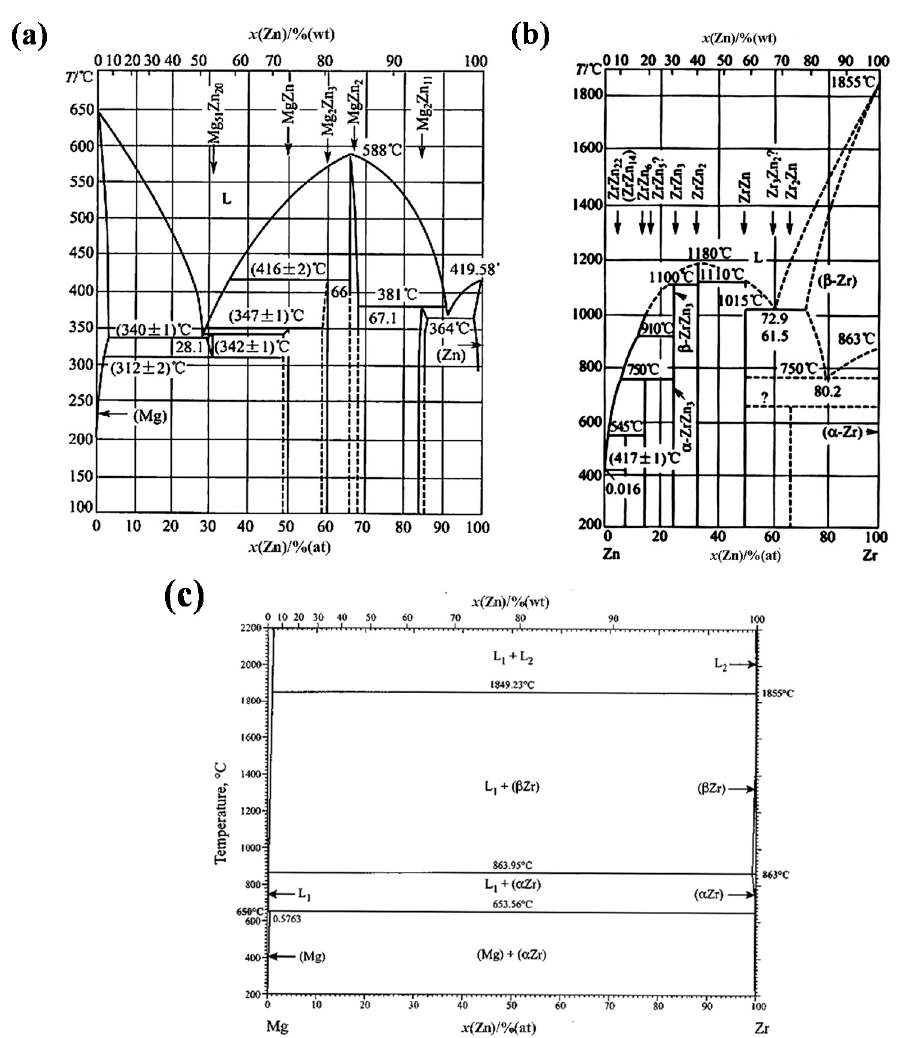
Figure 2. The Mg-Zn phase diagram ( a ), Zn-Zr phase diagram ( b ) adapted from [32], and the Mg-Zr phase diagram ( c ) adapted from [35], with permission from Springer,